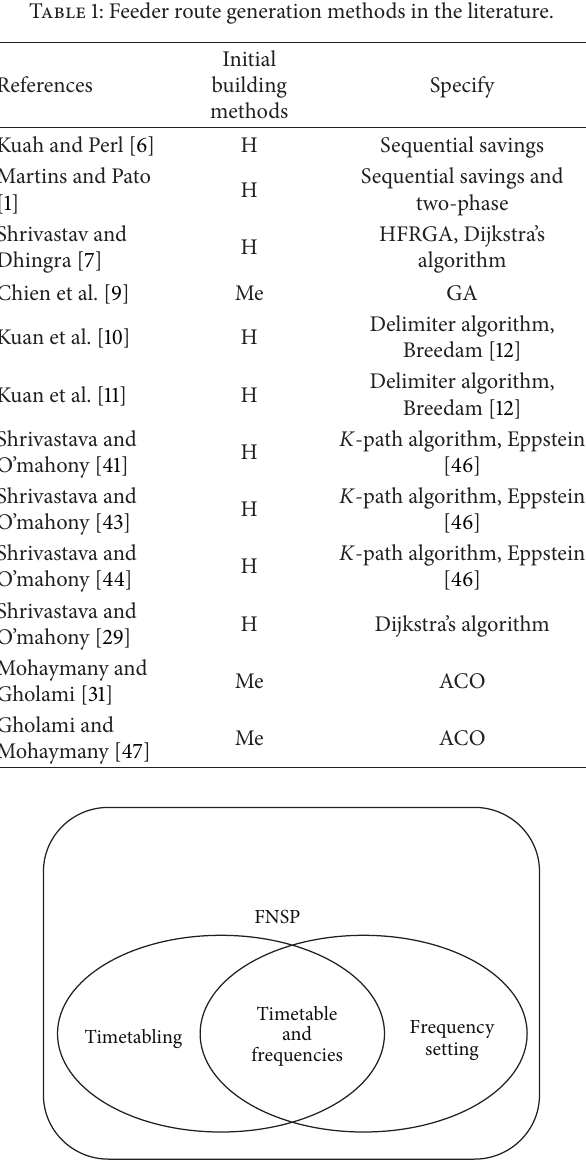
Figure 1: The schematic categorization of FNSP.